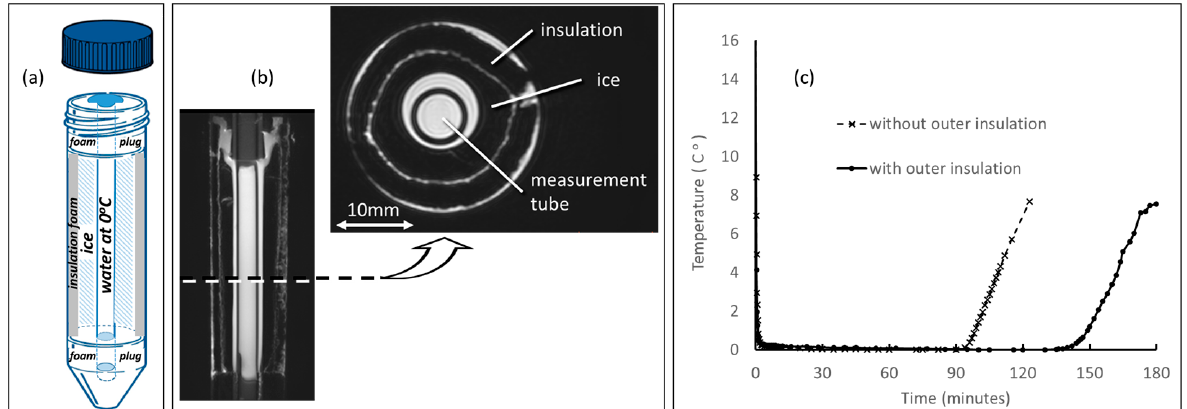
Figure 1. ( a ) Schematic of DWI phantom constructed from a 50 mL centrifuge tube designed to hold water in an 8 mm measurement tube at known temperature, thus with known diffusion coef- ficient. ( b ) Coronal and axial MRI with internal phantom components labeled. ( c ) Plot of measure- ment tube temperature versus time after measurement tube, initially at room temperature, is in- serted into frozen phantom. Note, thermal equilibrium at ≈ 0 °C is achieved.